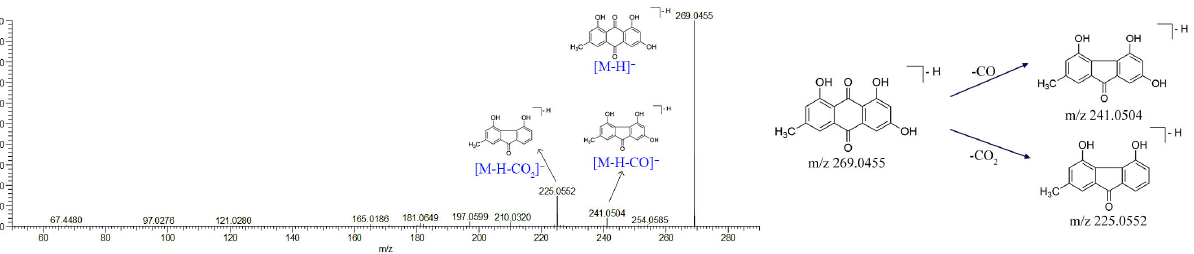
Figure 6. Characteristic of MS/MS spectra and possible fragmentation pathways of emodin.